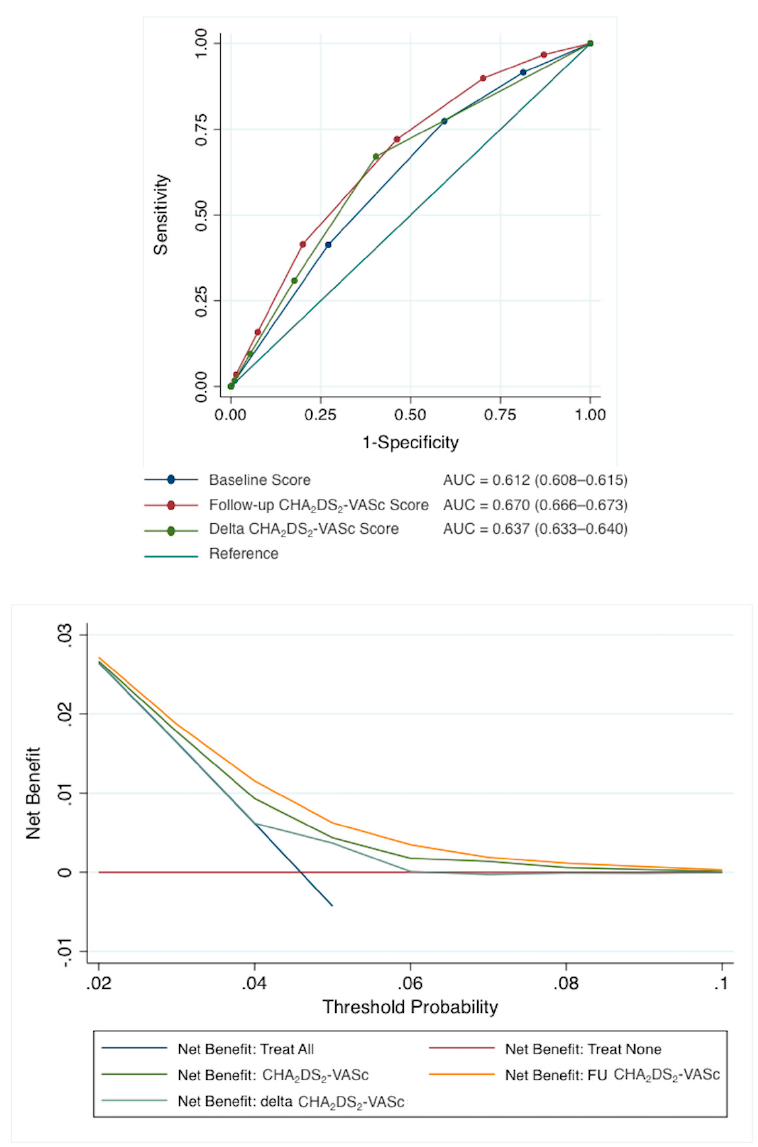
Figure 3. Upper panel: AUCs for the baseline follow-up and Delta CHA 2 DS 2 -VASc scores in predicting ischemic stroke. Lower panel: Decision curve analysis: net number of true positives gained with different models with different thresholds probabilities, compared to no model. AUC = area under curve